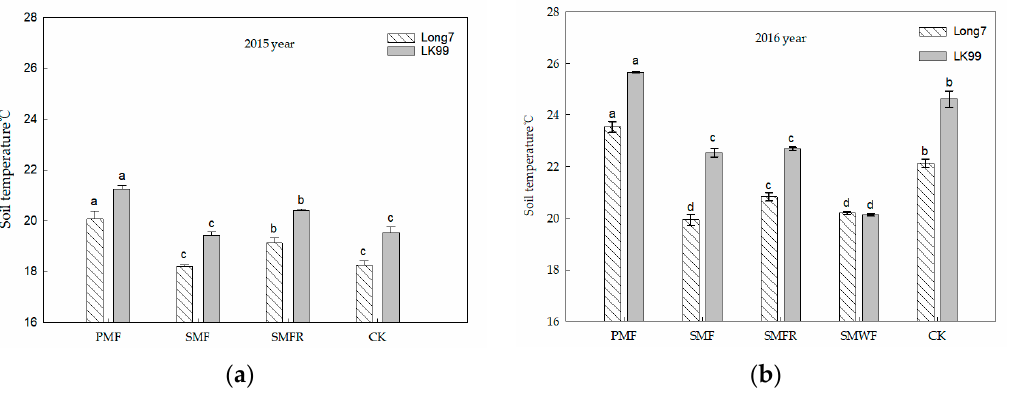
Figure 3. ( a , b ) Mean soil temperature in 0–25 cm during whole growth period under different treatments in ( a ) 2015 and ( b ) 2016. Data are means of three replicates. Different lower case letters in the same columnar section are significant differences at 0.05 level. Error bars are the standard deviation of means ( n = 3).